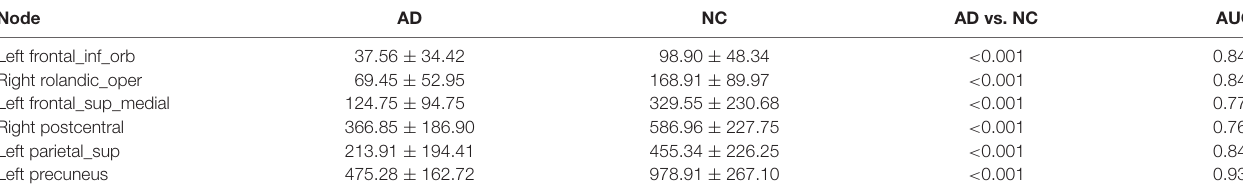
TABLE 3 | The group difference of nodal betweenness centrality in AD vs. NC and the diagnostic efficiency of the nodes in the differentiation between groups. Node AD NC AD vs. NC Left frontal_inf_orb